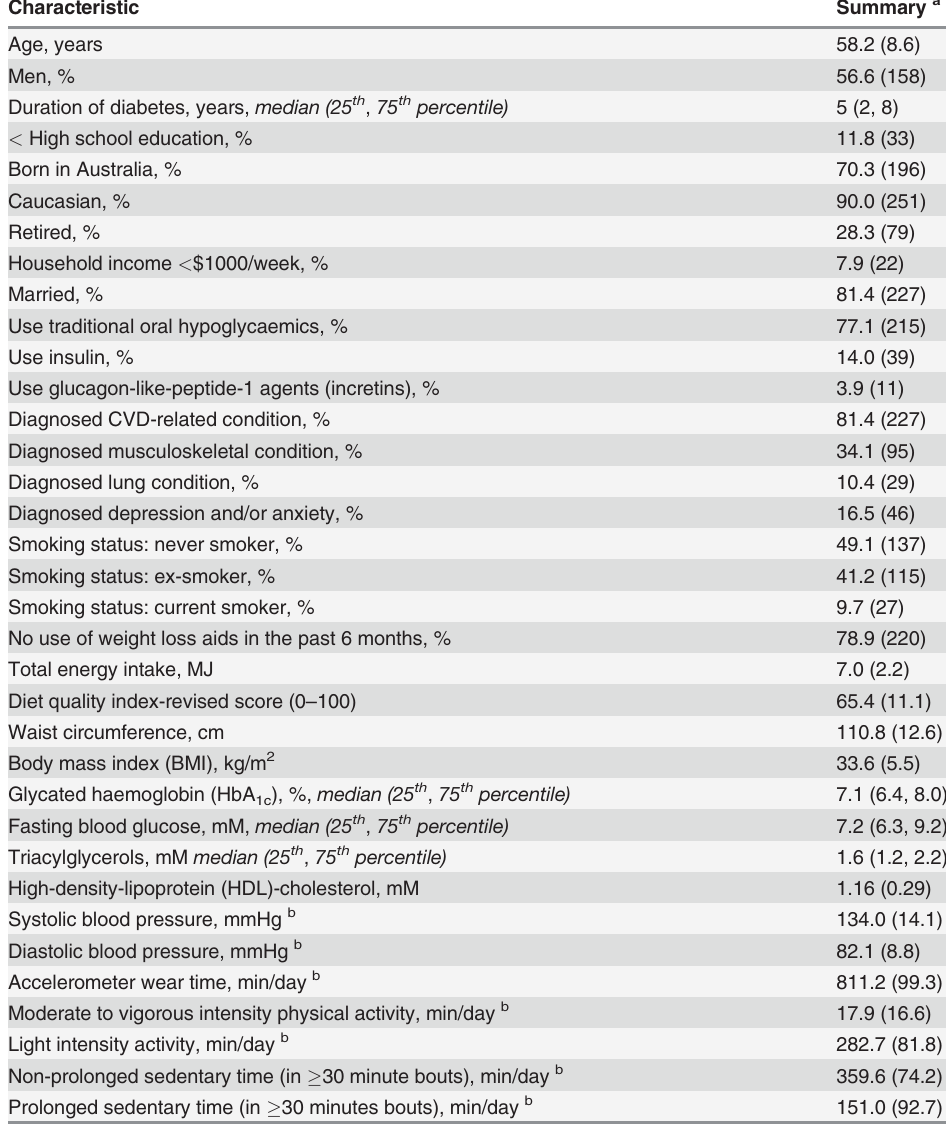
Table 1. Socio-demographic, clinical, and accelerometer derived activity characteristics of participants (n = 279).